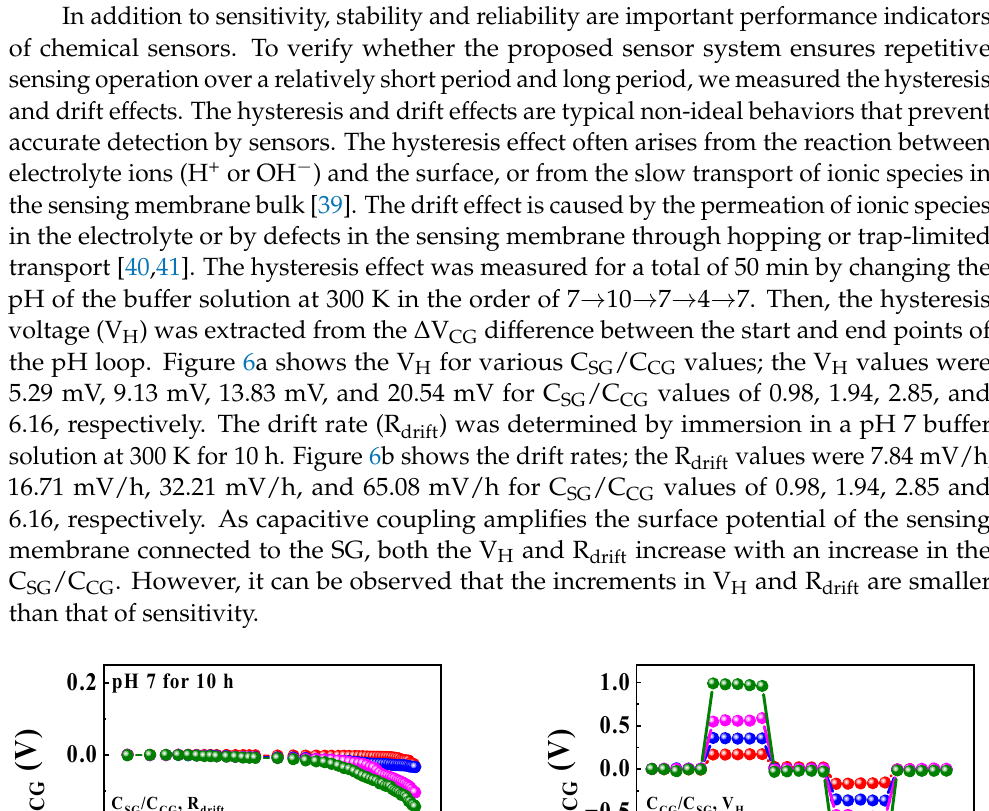
Table 2. pH sensing characteristics of the a-IGZO coplanar dual-gate TFT pH sensor. C SG /C CG